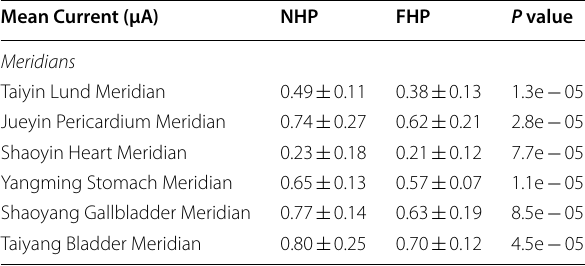
Table 3 The arithmetic means and standard deviation of the I of the Sanyang meridian of the hand and the Sanyin meridian of the foot